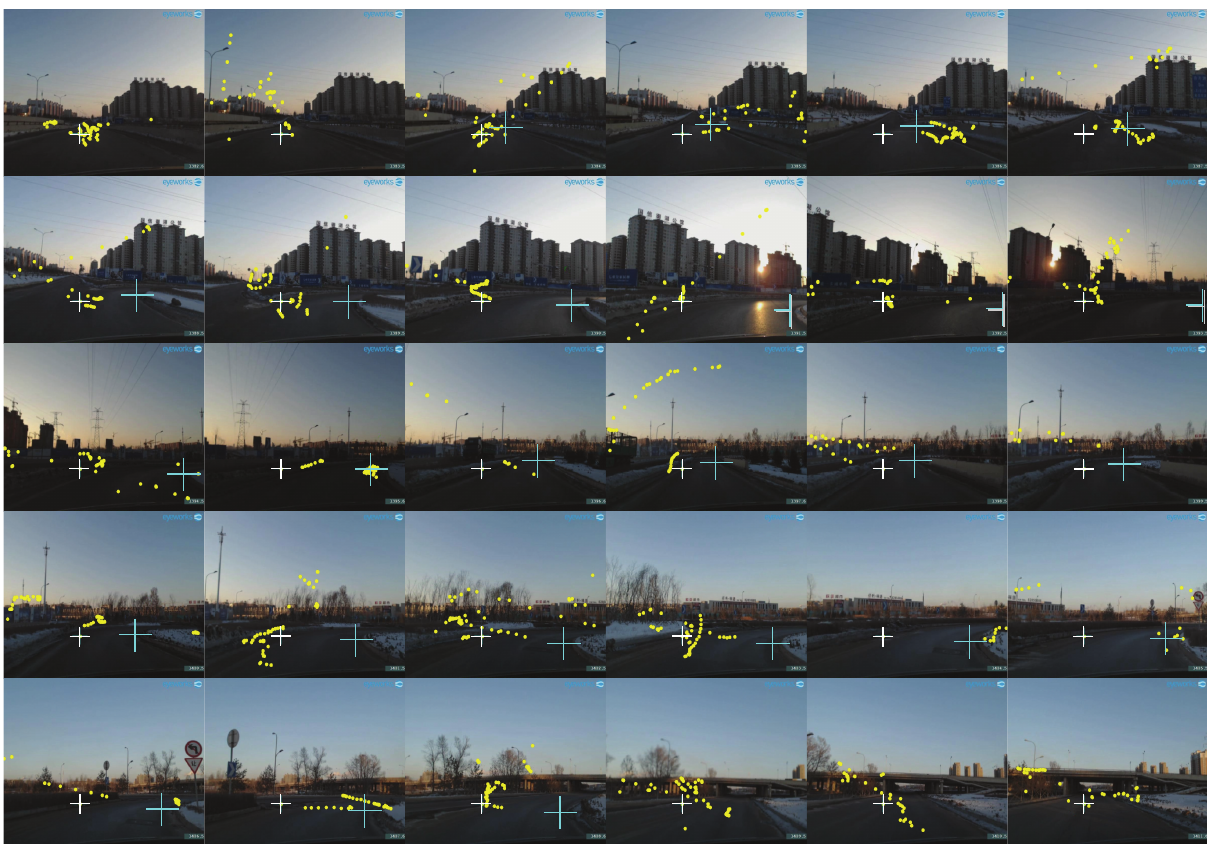
Figure 11: The distribution of fixation points on right-hand bends.